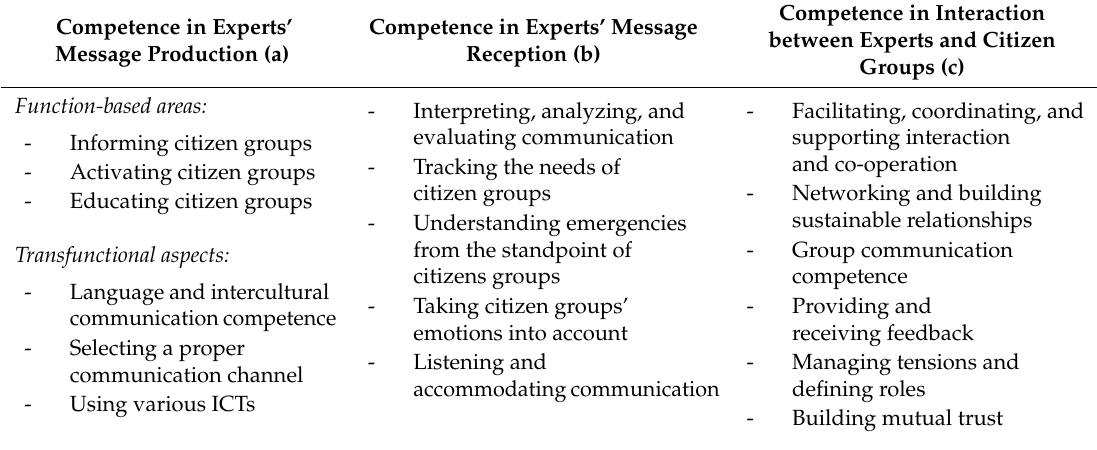
Table 1. The components of experts’ crisis communication